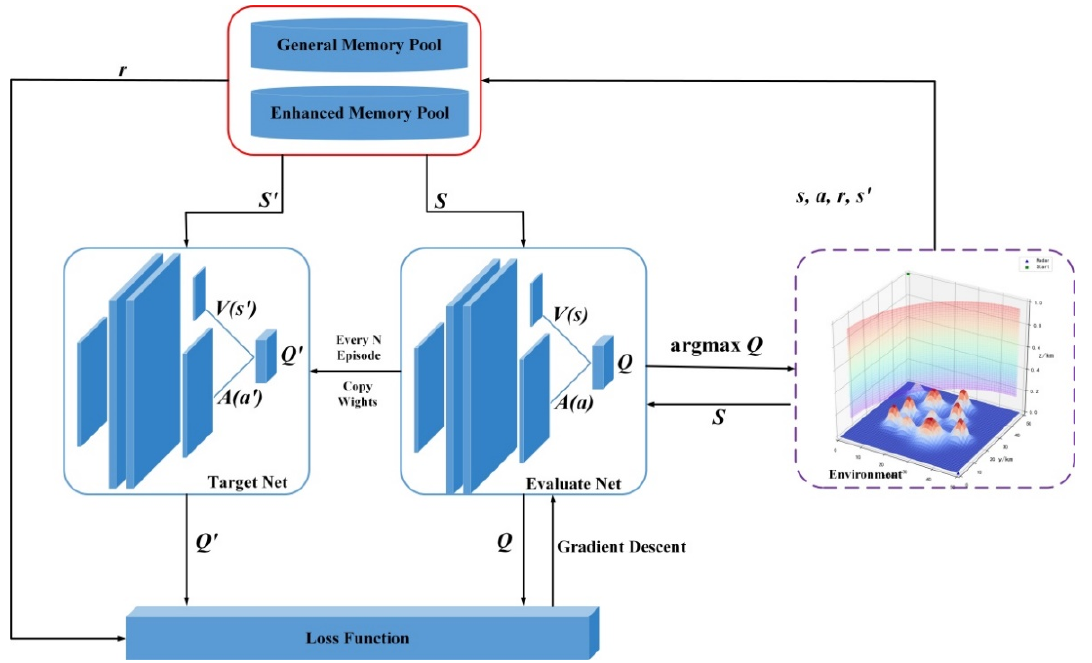
Figure 4. Memory-enhanced dueling deep q-network